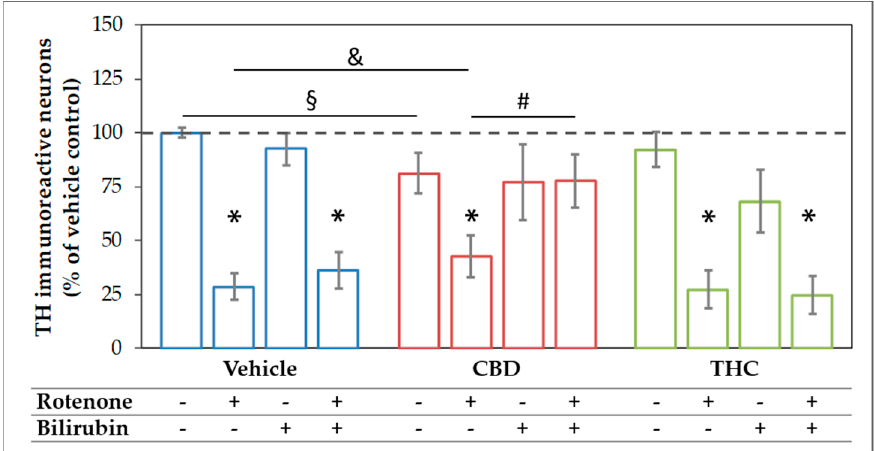
Figure 4. The combination of cannabidiol and bilirubin prevents rotenone-induced loss of neurons. Cells were treated with vehicle (DMSO), rotenone (80 nM), bilirubin (BR; 10 µ M), cannabidiol (CBD; 10 µ M), or tetrahydrocannabinol (THC; 10 µ M) for 48 h. After tyrosine hydroxylase (TH) immunocytostaining, dopaminergic (TH immunoreactive, THir) cells were counted. Data are displayed as mean ± SEM calculated from eight independent experiments ( n = 8). Statistical significance was determined using a Kruskal-Wallis test followed by a Mann-Whitney (U)-test. * indicates significant effects compared to the respective vehicle control (* p < 0.05). § indicates the effects vs. the respective group treated with CBs (§ p < 0.05). & indicates the effect of CBD supplementation on the rotenone treatment (& p < 0.05). # indicates the effects of BR supplementation (# p < 0.05). Exact p values for the group comparisons are shown in the supplementary material (Table S3).